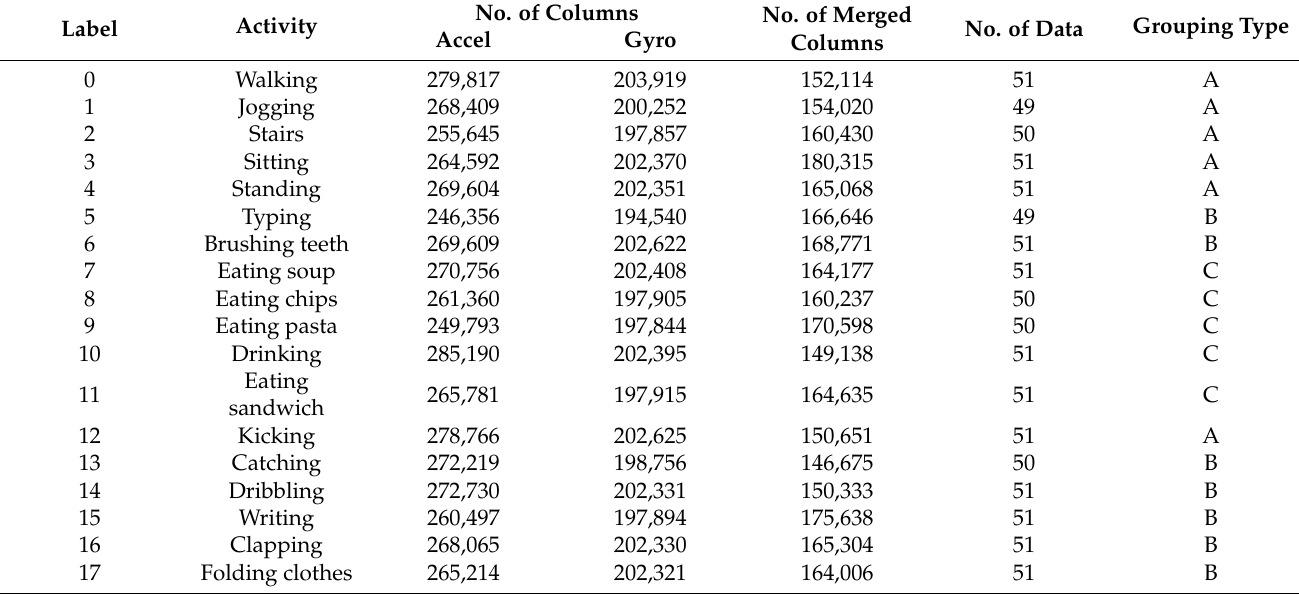
Table 1. Smartphone acceleration and gyroscope data from the WISDM